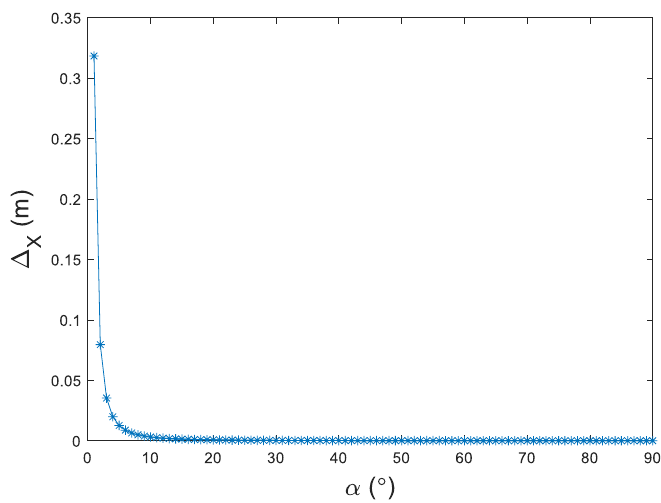
 vs. azimuth  Figure 7. ∆ X X vs. azimuth α .